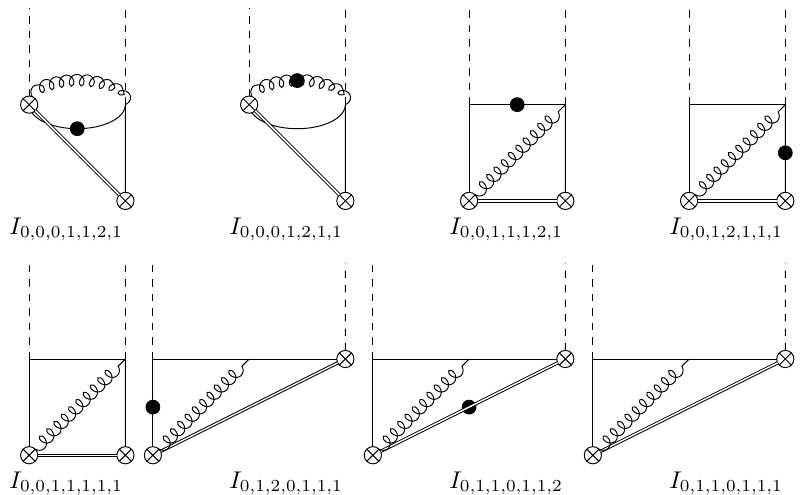
Figure 6. The pre-canonical master integrals for the real corrections to D t → H . The black dots represent squared propagators.